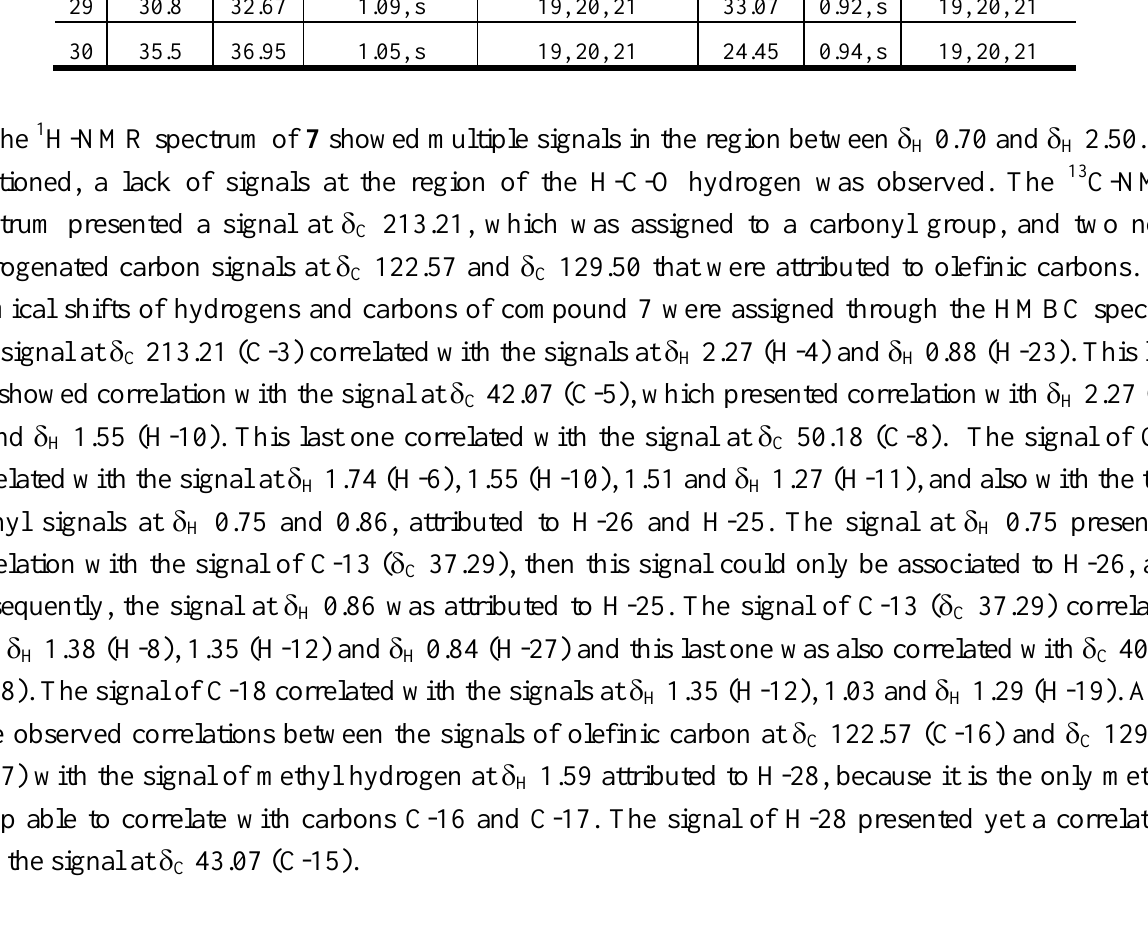
Figure 3. Some correlations observed in NOESY spectrum of 3-oxo-16-methylfriedel-16-ene ( 7